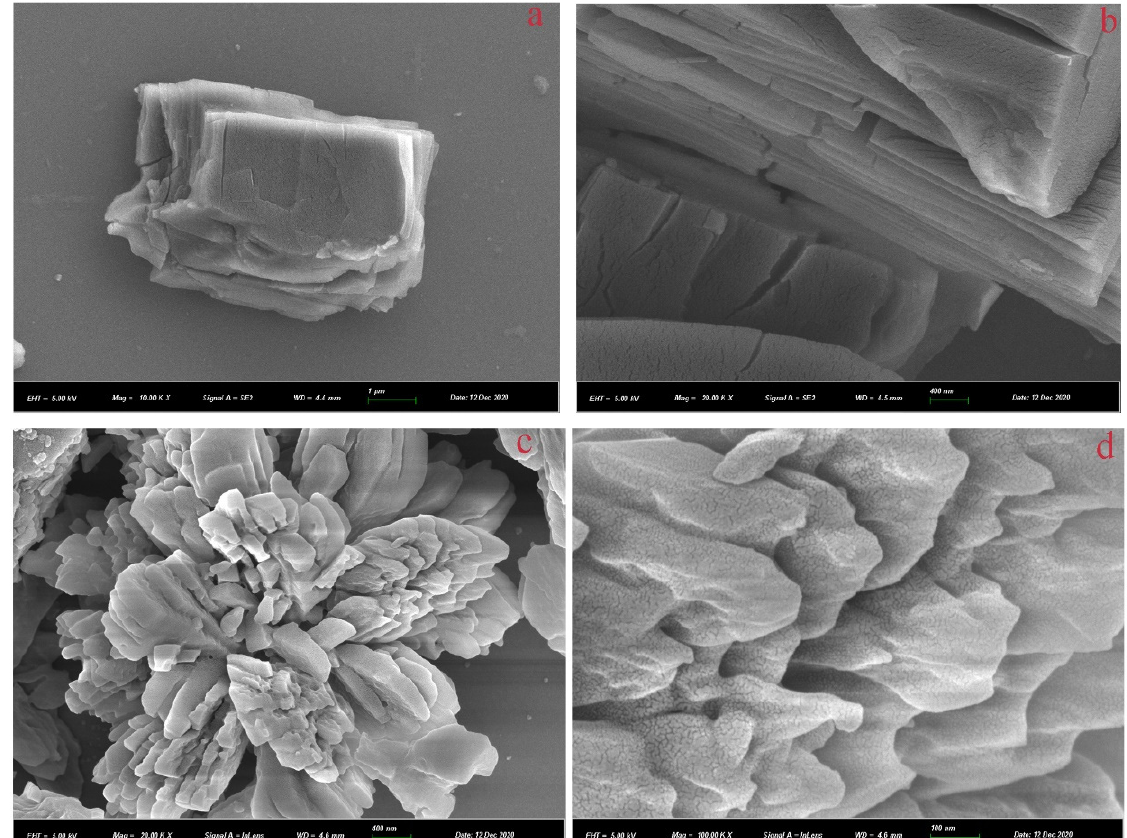
Figure 3. SEM images of the MOF ( a , b ) and MOF@P ( c , d ).